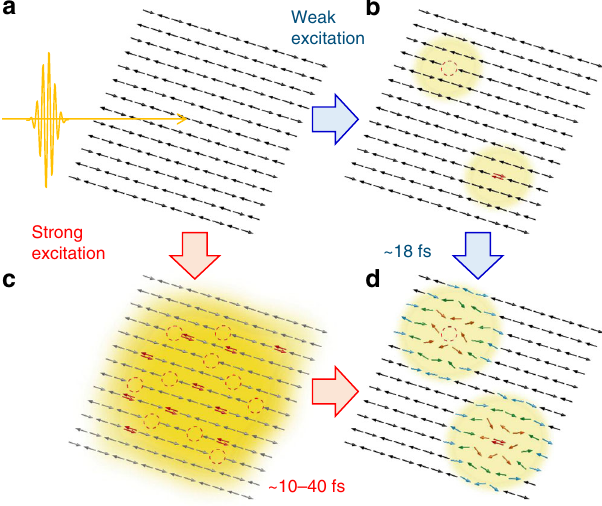
Fig. 5 A schematic of the ultrafast photoresponses in Nd 2 CuO 4 . a The Mott insulator state. b , c Generation of b low density and c high density of doublons and holons just after the photoirradiation. d Formations of